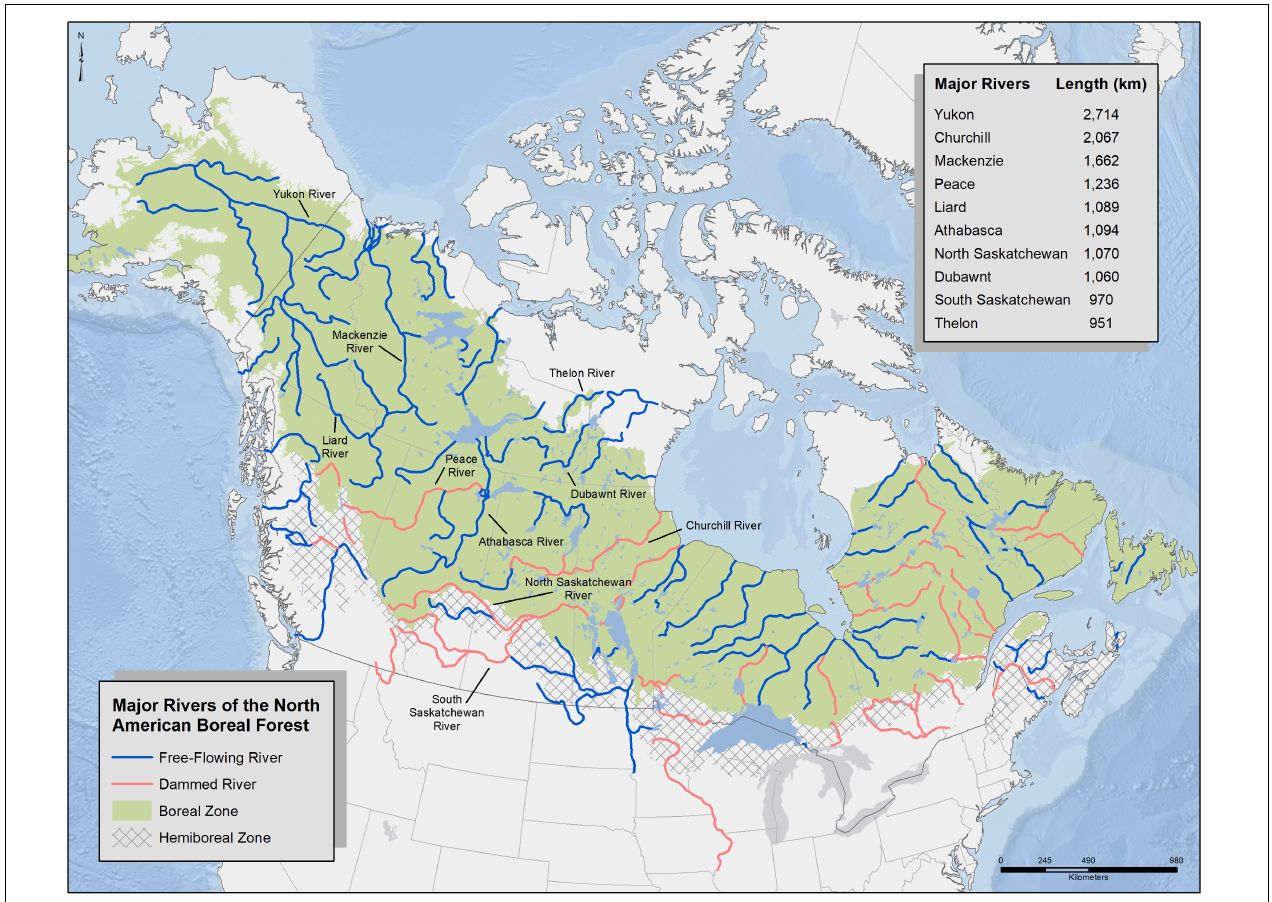
FIGURE 4 | The North American Boreal Forest biome encompasses most of the continent’s remaining, large undammed rivers, which maintain globally significant water, nutrient, and migratory fish movements between terrestrial and ocean